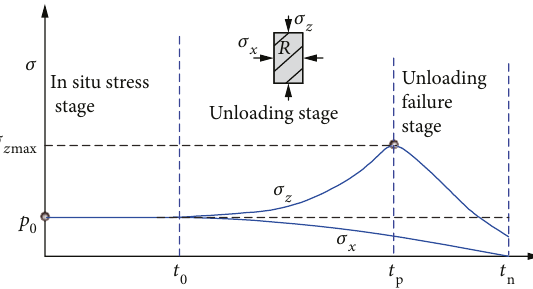
Figure 3: Stress variation of the rock mass unit ( R ) with the advancing of the working face, and t is the time of the stress variation